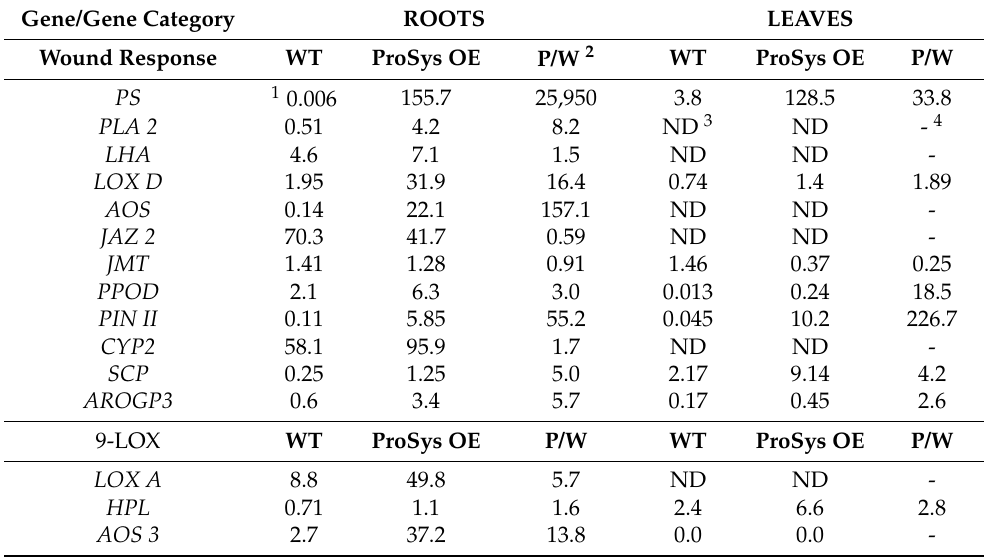
Table 5. Relative expression levels of wound-response and 9-LOX pathway genes in wild-type (WT) and prosystemin overexpressing (ProSys-OE) tomato plants. Genes were quantified in roots and leaves of WT untransformed plants and in plants overexpressing the ProSys precursor protein of the systemin peptide